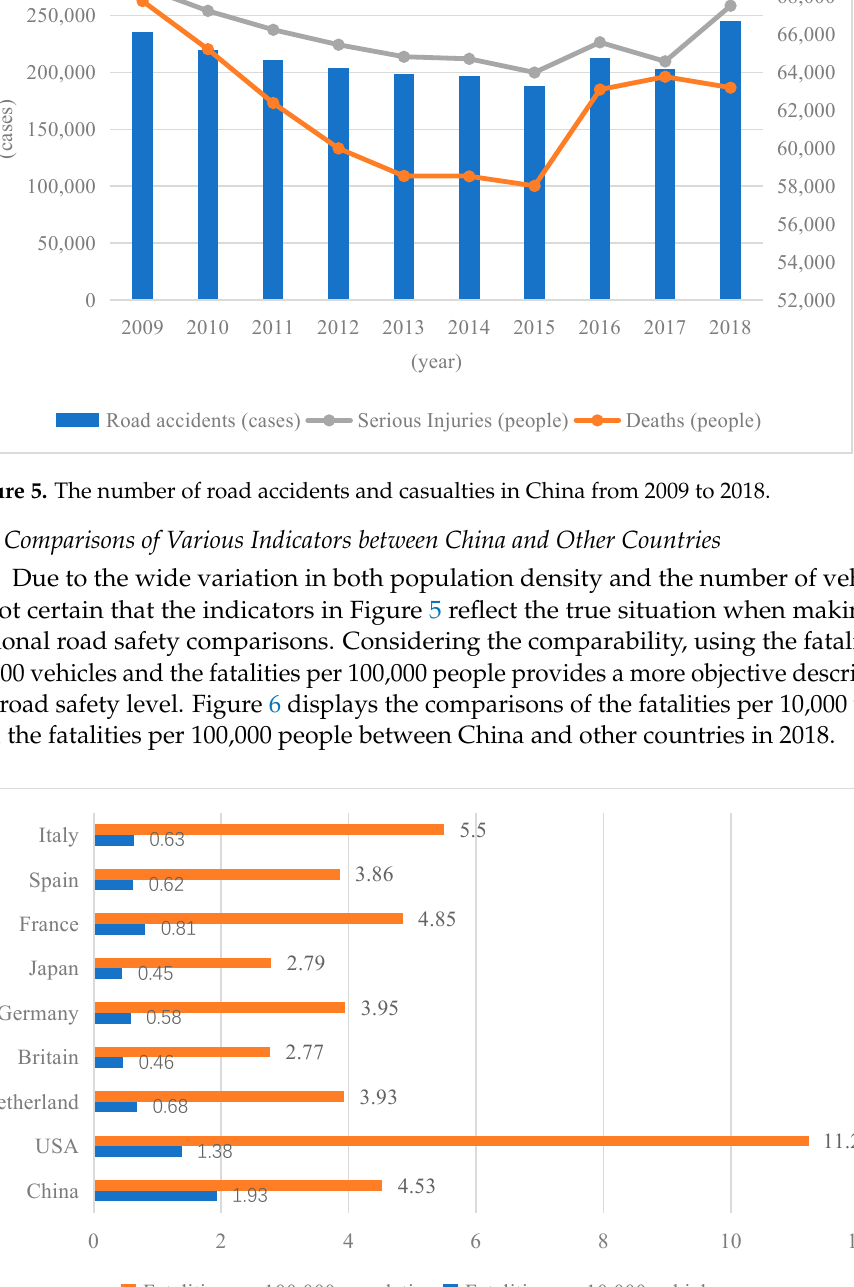
Figure 5. The number of road accidents and casualties in China from 2009 to 2018.